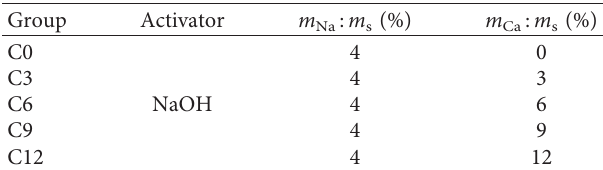
Table 5: Compositions of alkali-activated slag (AAS) cement.